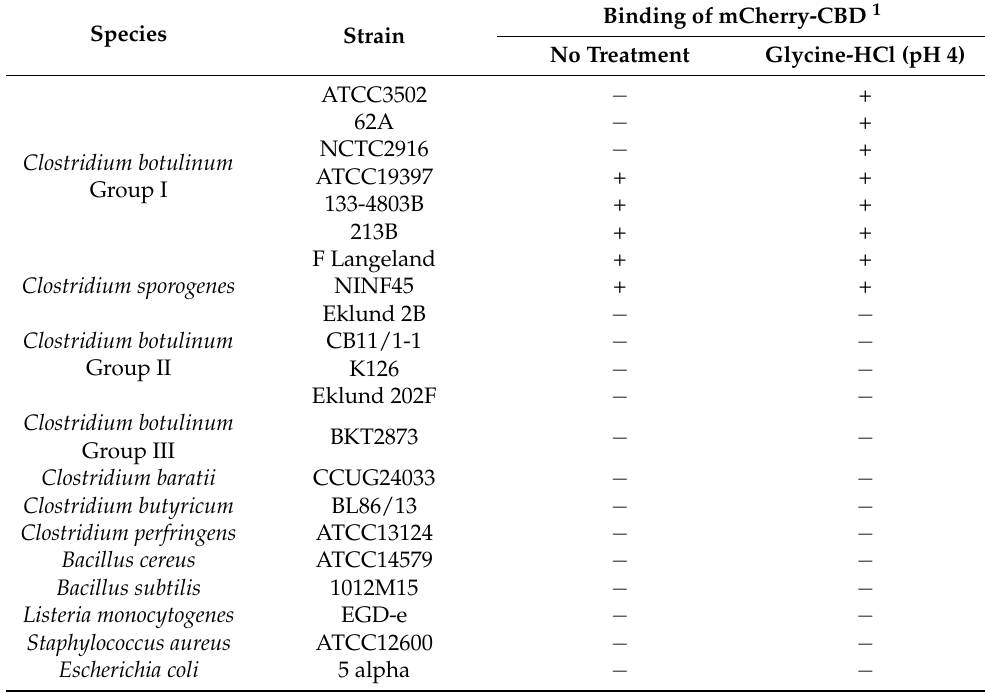
Table 1. Binding of mCherry-CBD to Clostridium botulinum and other